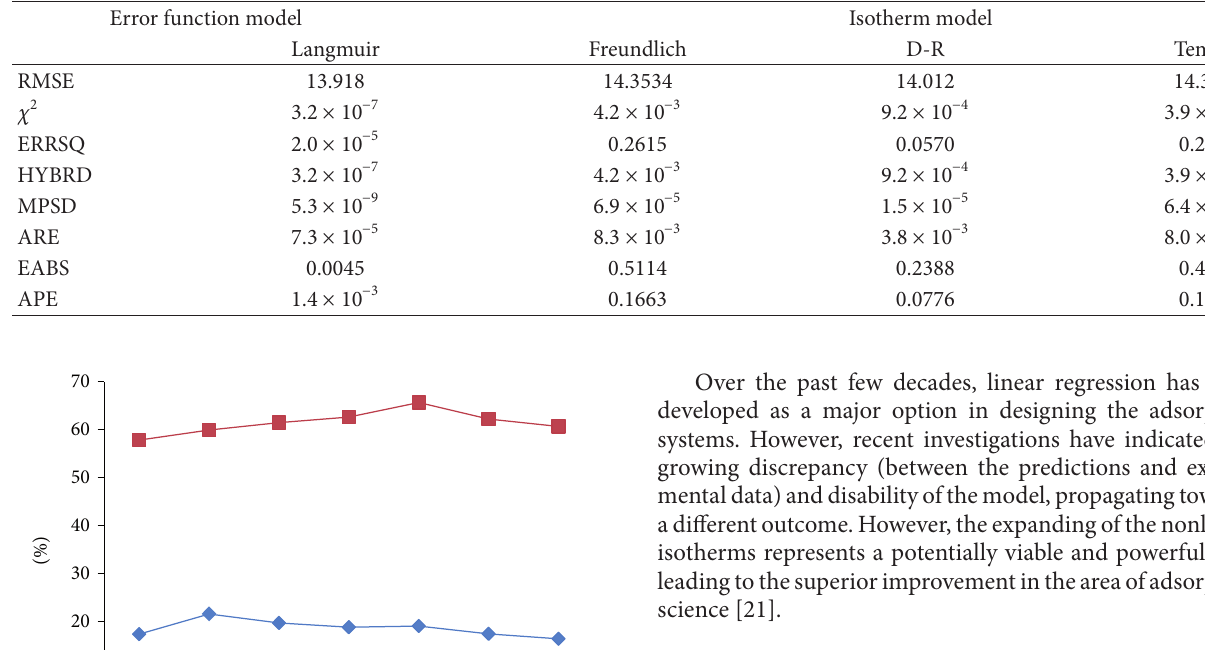
T 3: Values of error function of the isotherm models of Cr (VI) onto MVM.